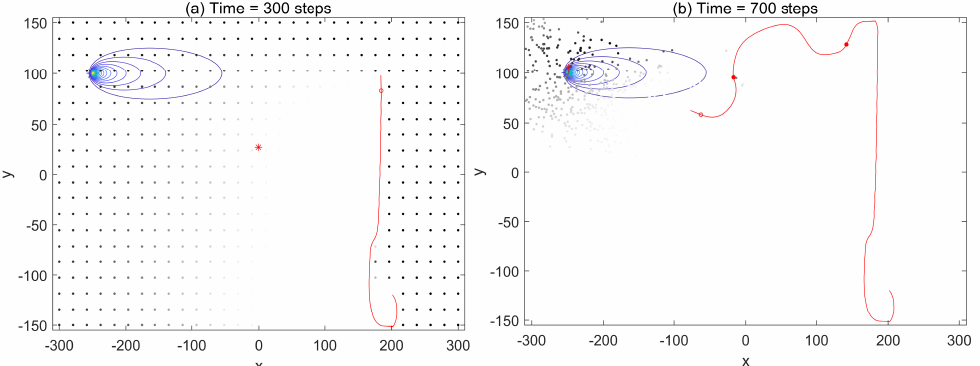
Figure 7. The trajectory (red line), detections (red solid circles), estimated source (red star), and particles (black dots) of the mobile sensor platform using the free energy scheme ( T = 10 4 ). The source location at ( − 250,100 ) with the contour plot of the corresponding mean